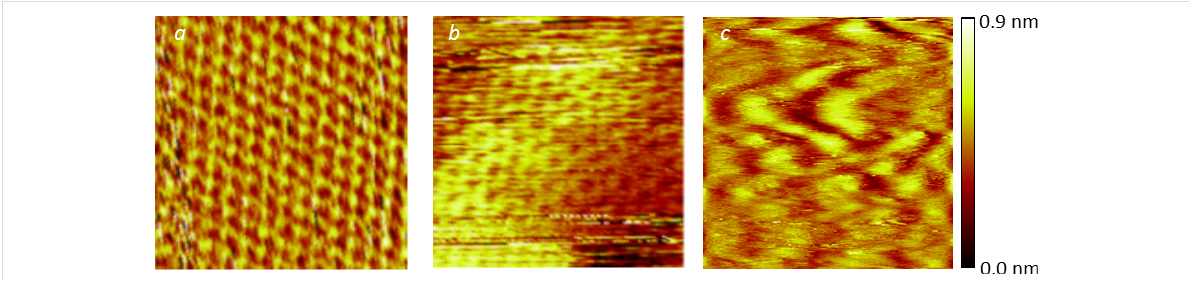
Figure 1: Structural characterization of the substrates. STM images (2.3 × 2.3 nm 2 ) of a HOPG surface (a) and CVD monolayer graphene transferred onto a fused quartz plate (b: 2.3 × 2.3 nm 2 and c: 50 × 50 nm 2 ). The images were acquired under air atmosphere, in the height (constant current) mode. The setpoint current was I S = 100 pA, and the bias was V T = 200 mV. The height scale is also shown for graphene on quartz